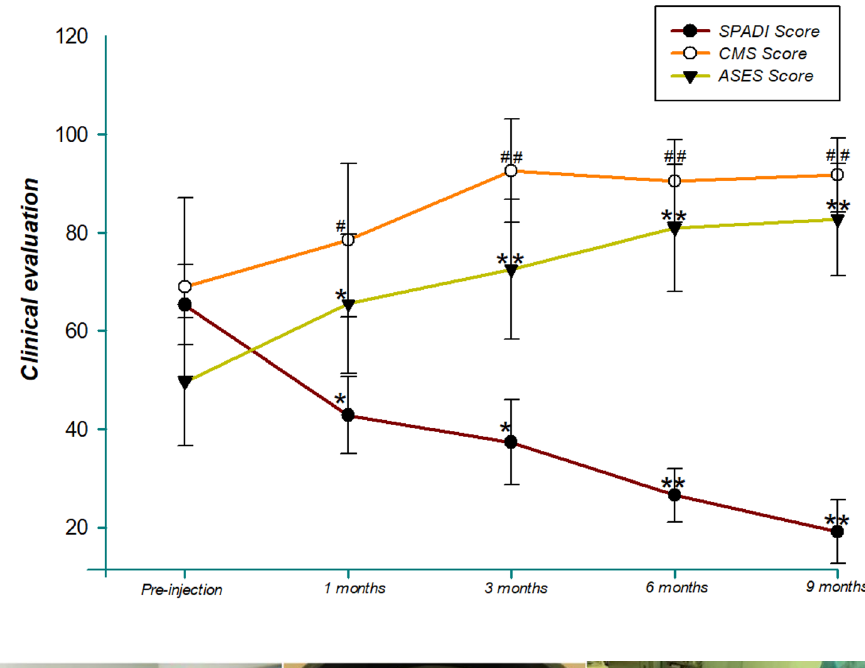
Fig. 2 The procedure of ultra- sound-guided injection of PRP with betamethasone for sympto- matic partial rotator cuff injury (figure above). In the MRI data, statistical pre-and post-com- parisons revealed statistically significant differences between location of partial rupture and the grade of